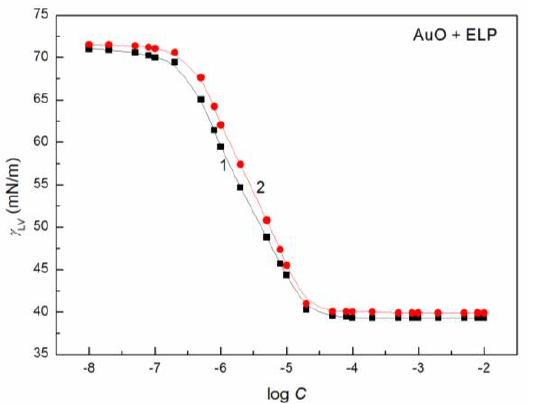
Figure 2. A plot of the surface tension ( 𝛾 𝐿𝑉 ) of aqueous solutions of ELP (curve 1, squares) and AuO + ELP mixture (curve 2, circles) vs. the logarithm of ELP concentration (log C ).